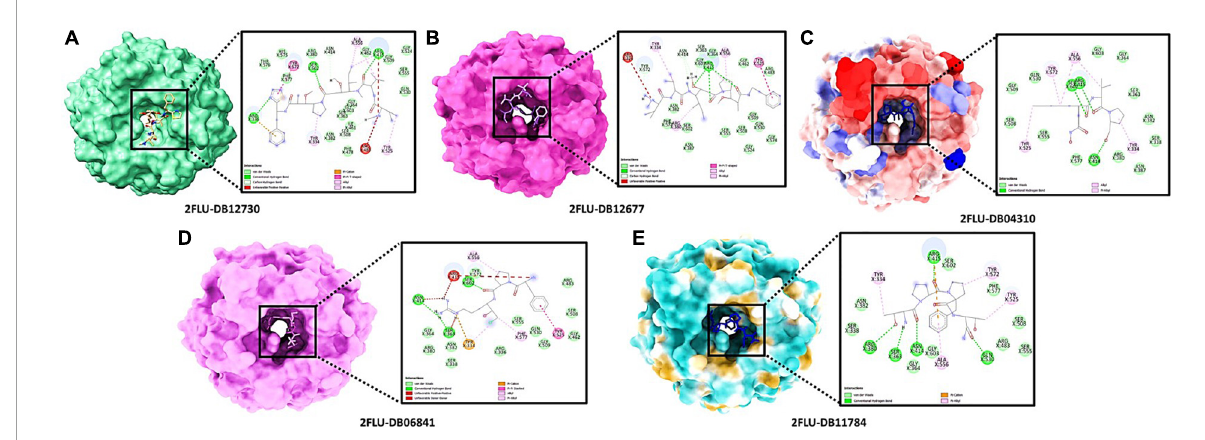
FIGURE5 Describes the docking pose of Pdb: 4IFN and our 5 selected drug molecules.